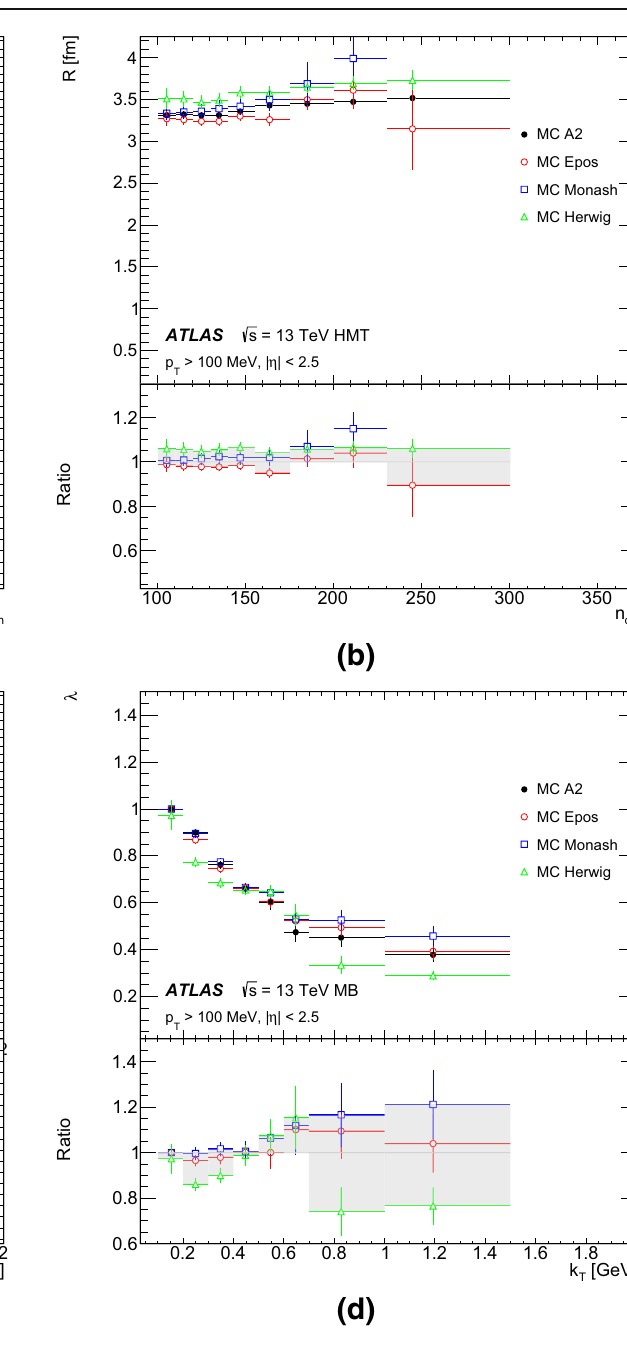
plot shows the ratio of the BEC parameters obtained using EPOS LHC (red circles), Pythia8 Monash (blue squares) and Herwig++ UE- EE- 5 (green triangles) compared with the parameters obtained using Pythia8 A2 . The grey band in the lower panels is the MC systematic uncertainty, obtained as explained in the